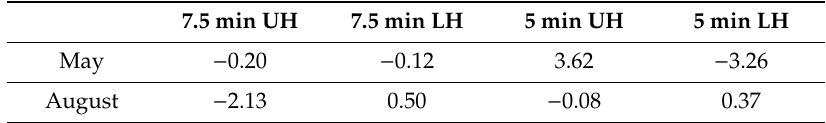
Table 2. Relative di ff erence in percentage (%) of the loss of TAN for the simulated fluxes compared to AGM flux. UH and LH refer to starting simulation in upper or lower